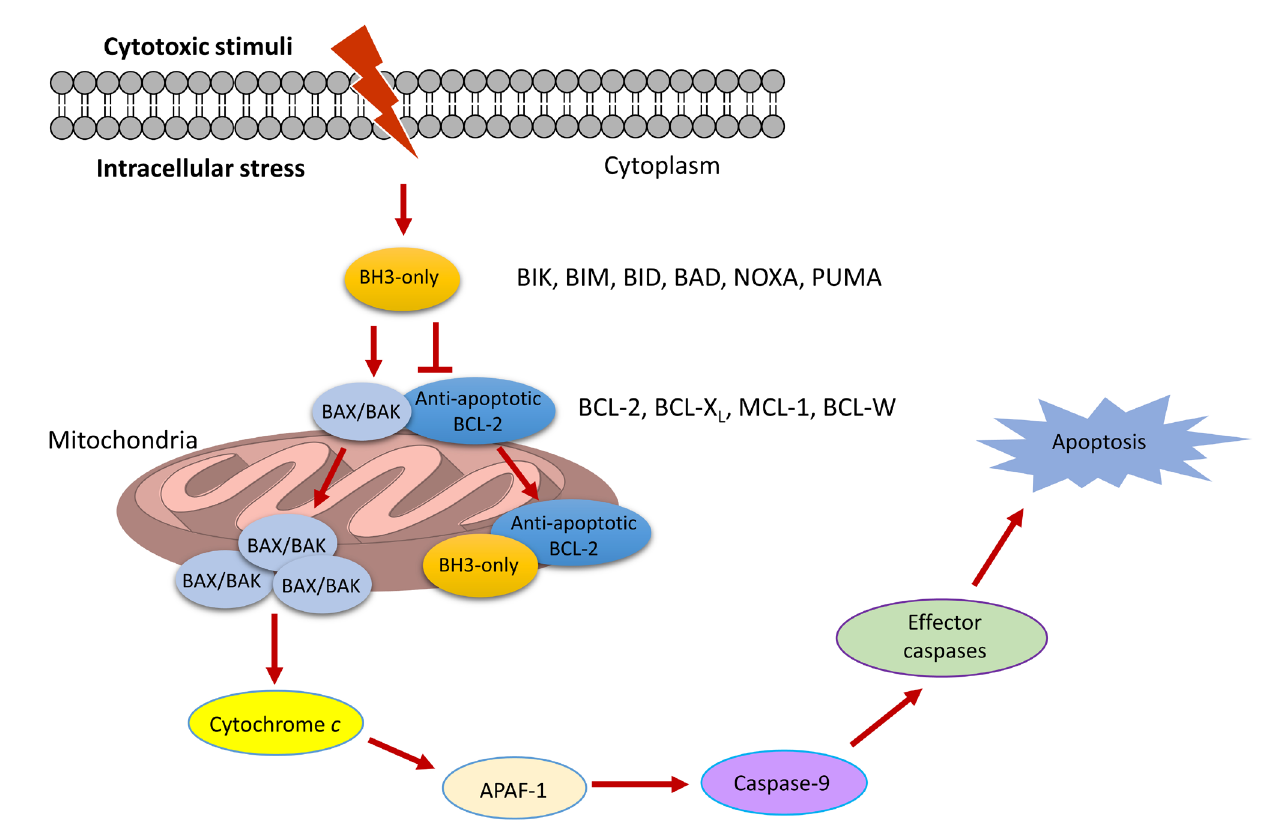
Figure 1. BCL-2 family proteins regulate mitochondria-mediated intrinsic apoptosis